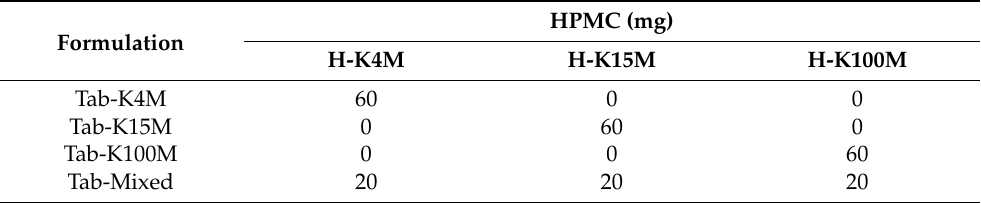
Table 1. Formulation of compressed HPMC-based matrix